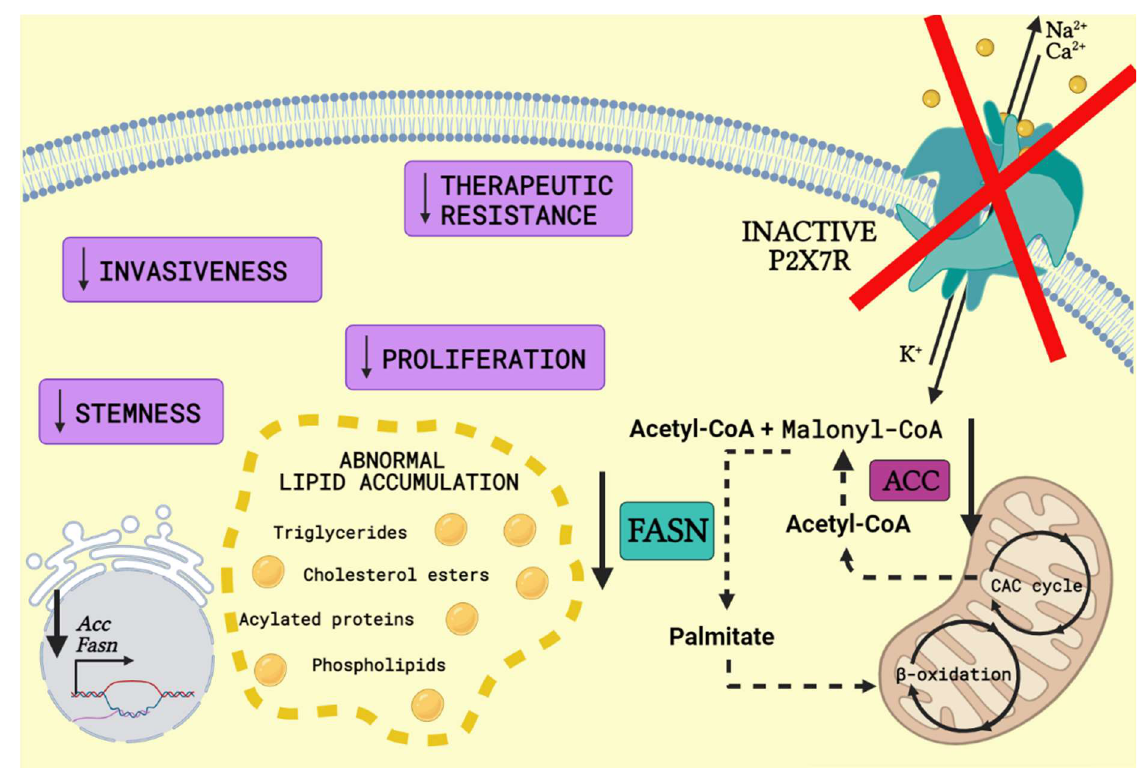
Figure 2. P2X7 receptor knockout or antagonism in FA metabolism. P2X7 receptor (P2X7R) knockout or antagonism reduces mRNA and protein expression level of fatty acid metabolism key enzymes such as acetyl-CoA carboxylase (ACC) and fatty acid synthase (FASN). ACC converts acetyl-CoA generated from citric acid cycle (CAC cycle) into malonyl-CoA. Following, FASN catalyses the conversion of acetyl-CoA and malonyl-CoA into palmitate, which enters mitochondria and goes through β-oxidation, producing long-chain saturated fatty acids. The knockout or antagonism of P2X7R surprisingly results in abnormal lipid accumulation, such as higher serum triglyceride and cholesterol levels, which is associated with hepatic steatosis [75]. Moreover, FASN inhibition is related to a decrease in the number of cancer stem cells, proliferation, invasiveness and resistance to therapy (Created with BioRender.com).